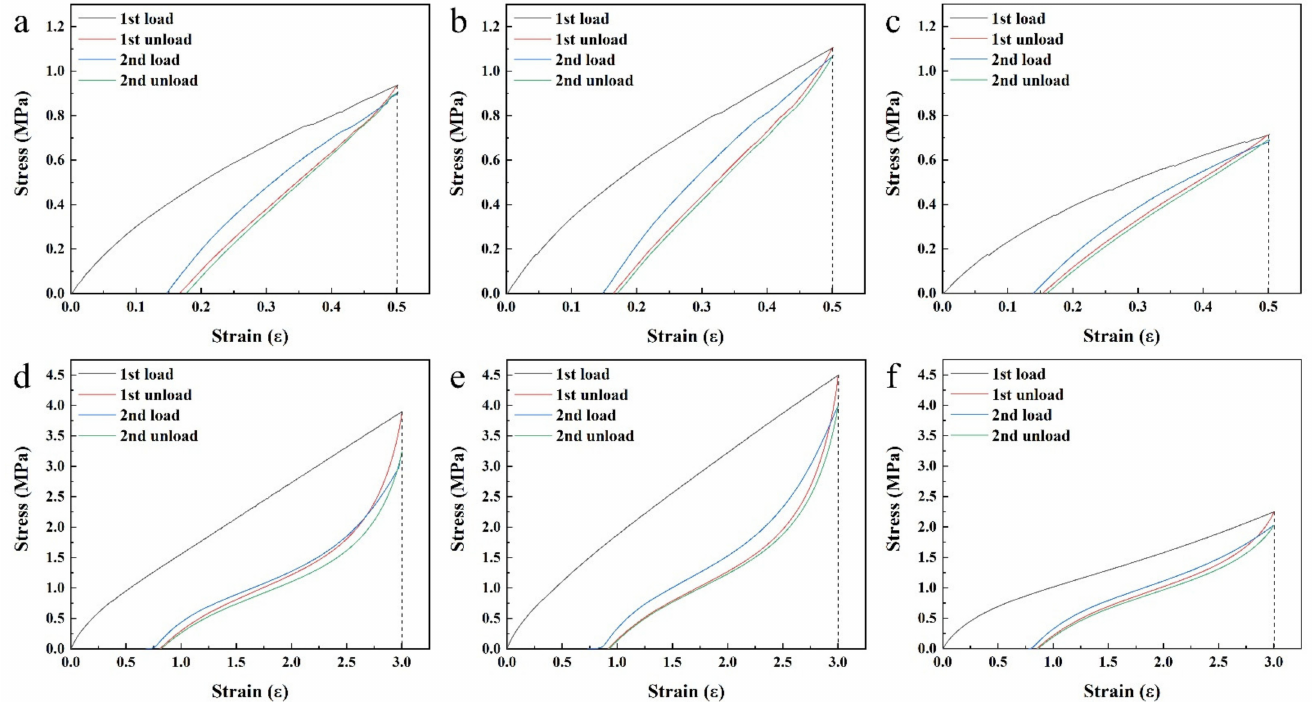
Figure 4. Stress–strain response of SiCB-NR/BR ( a , d ), SiCB-MNR 3 /BR ( b , e ) and M 1 SiCB-NR/BR ( c , f ) subjected to uniaxial cyclic tension with different strain ( a – c , ε = 0.5; d – f , ε =